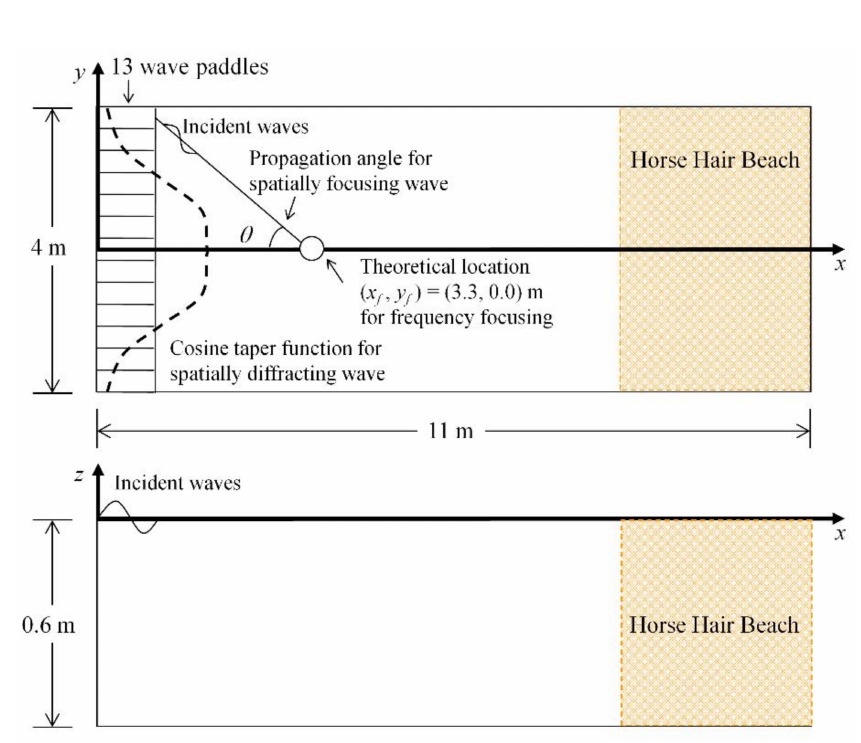
Figure 17. Sketch of the experimental setup by Wu and Nepf